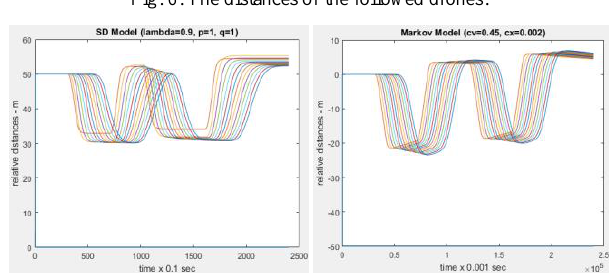
Fig. 9. The impact of SD model parameters on the velocity.